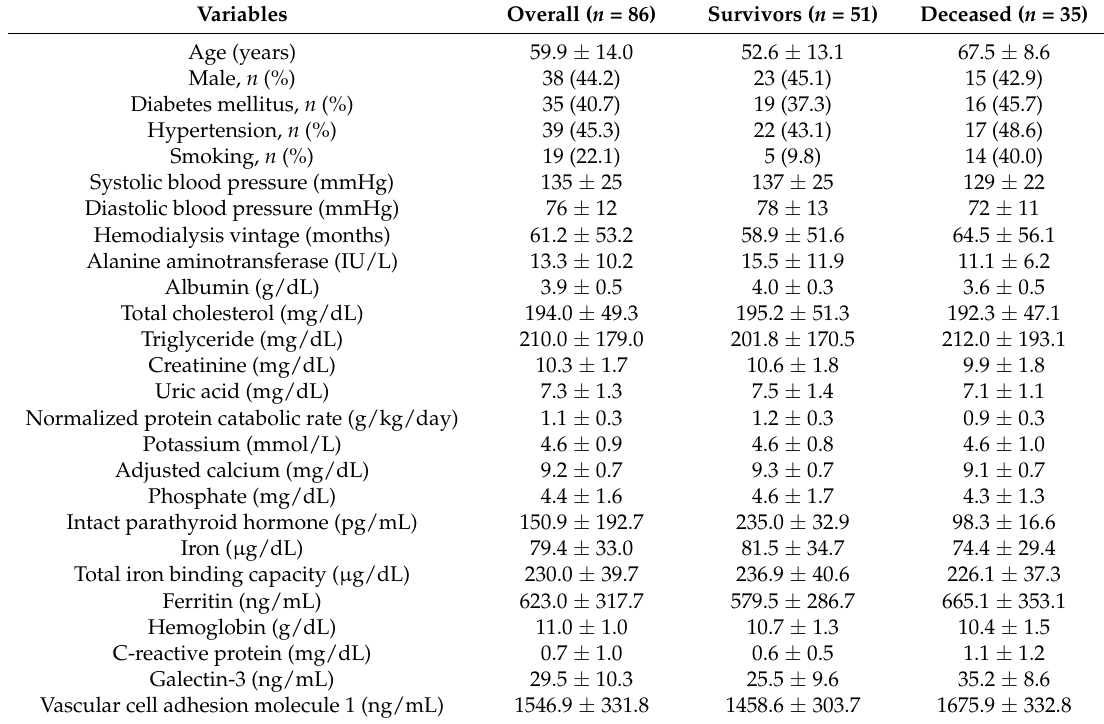
Table 1. Bio-clinical data of the whole study population with comparison between survivors and non-survivors.